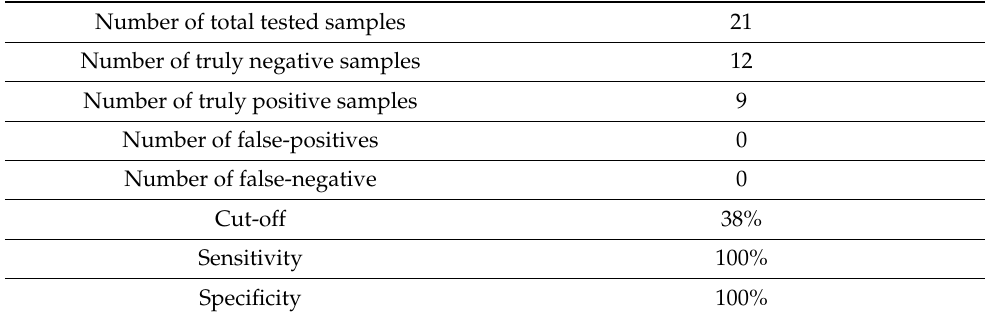
Table 2. Parameters found for the ELISA modified NAb detection assay.